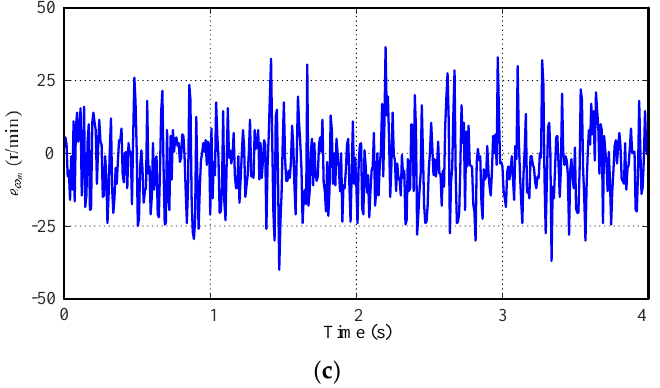
Figure 23. Speed responses with varied parameters 2 r s , 0.5 L d , 0.5 L q , and 2 J at 50 r/min. ( a ) speeds. ( b ) proposed predictive controller. ( c ) PI errors.